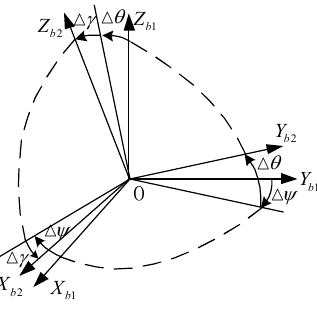
Figure 2. The misalignment angles between two systems.